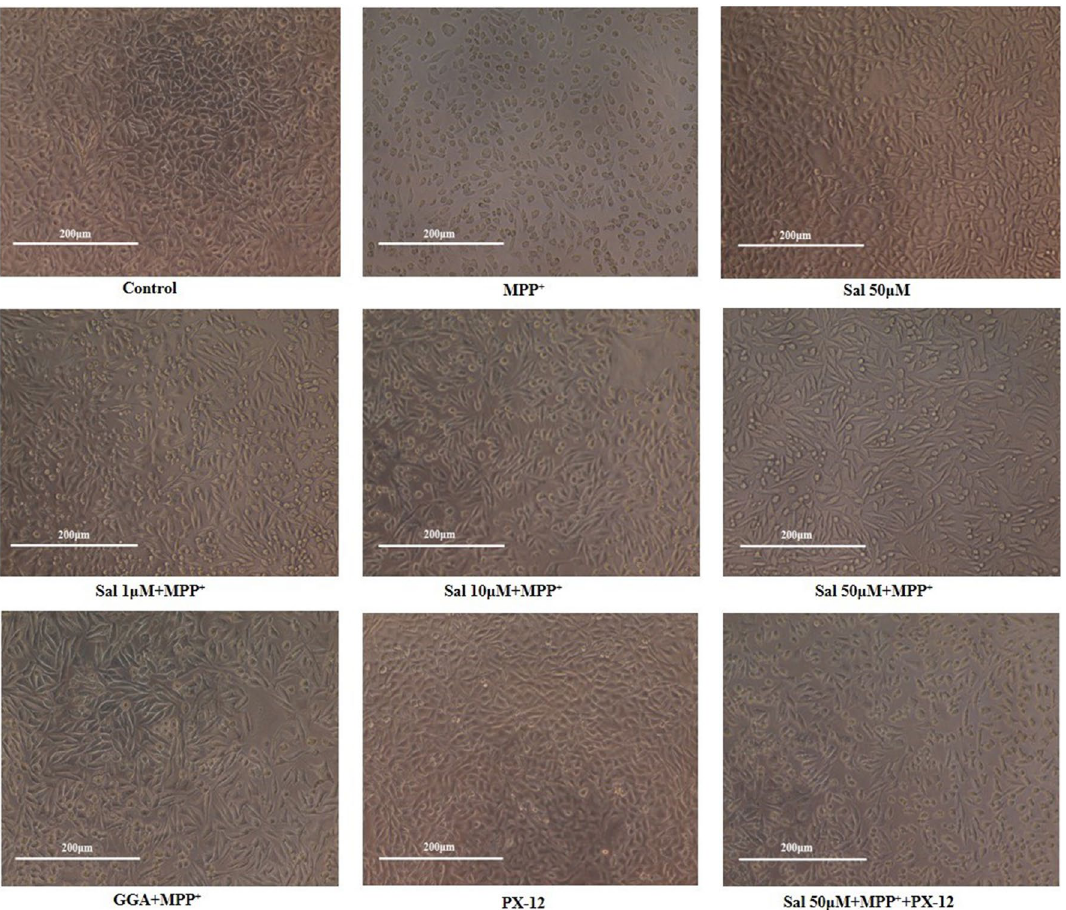
Figure 2. Protective effect of Schisanhenol (Sal) on morphology of SH-SY5Y cells treated with MPP + via Trx1. Cells were pre-incubated in various doses of Sal (1 µM, 10 µM, and 50 µM) for 24 h before exposed to MPP + (500 μΜ) for 48 h. Images were obtained with inverted phase-contrast microscope (100 ×). Representative images from six separate experiments were shown. Each experiment was conducted in triplicate. Scale bar, 200